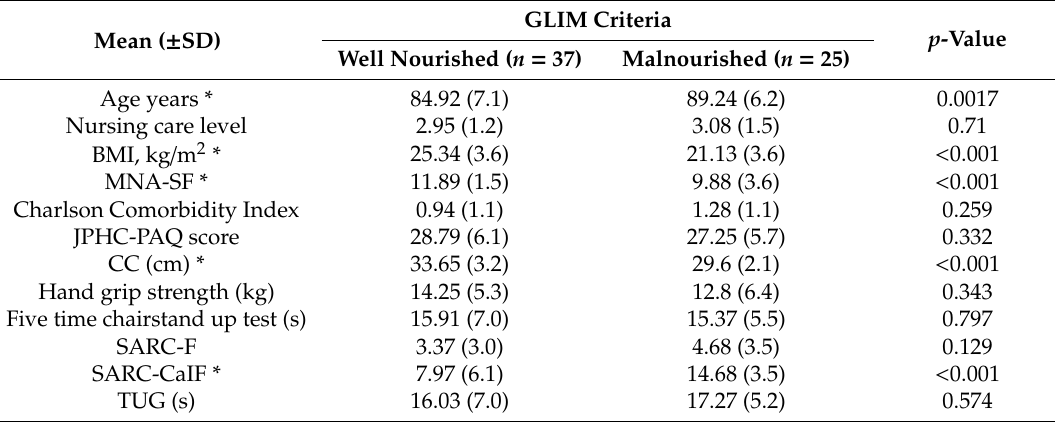
Table 2. Factors associated with